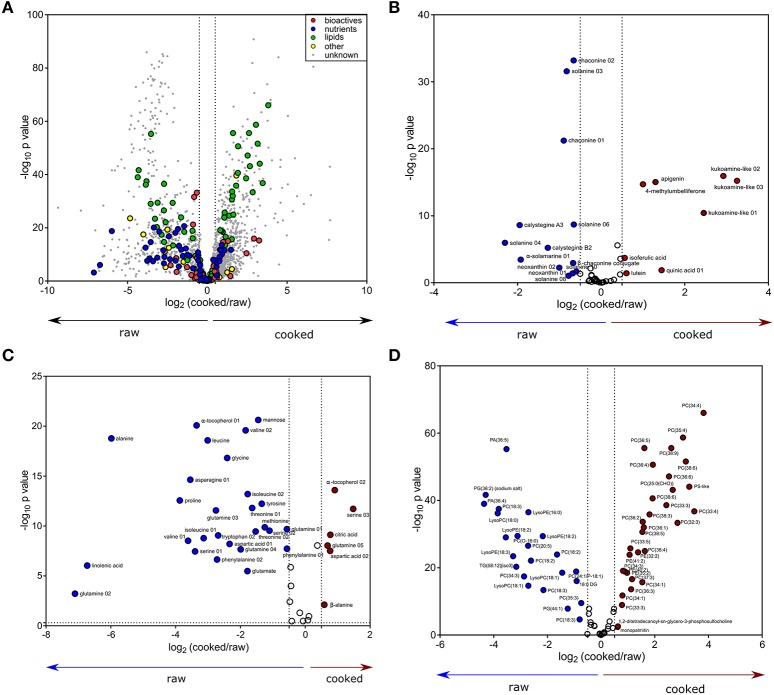
Variation in cooked and raw potato tuber metabolites. (A) Volcano plot for the differential abundance (log2 cooked/raw, x-axis) and significance (–log10 FDR adjusted p-value, y-axis) of 2,656 metabolites (colored circles) detected by UPLC- and GC-MS across 60 cultivars of raw and cooked potato tubers. Color represents metabolite class, and vertical dashed lines are a threshold of cooked/raw [log2(cooked/raw) < -0.5 or >0.5]. Subsets of the volanco plot in (A) were recreated for (B) bioactives, (C) nutrients, and (D) lipids. The subset volcano plots are colored to indicate metabolites reduced during cooking (blue), increased during cooking (red), or metabolites that did not vary due to cooking (white).